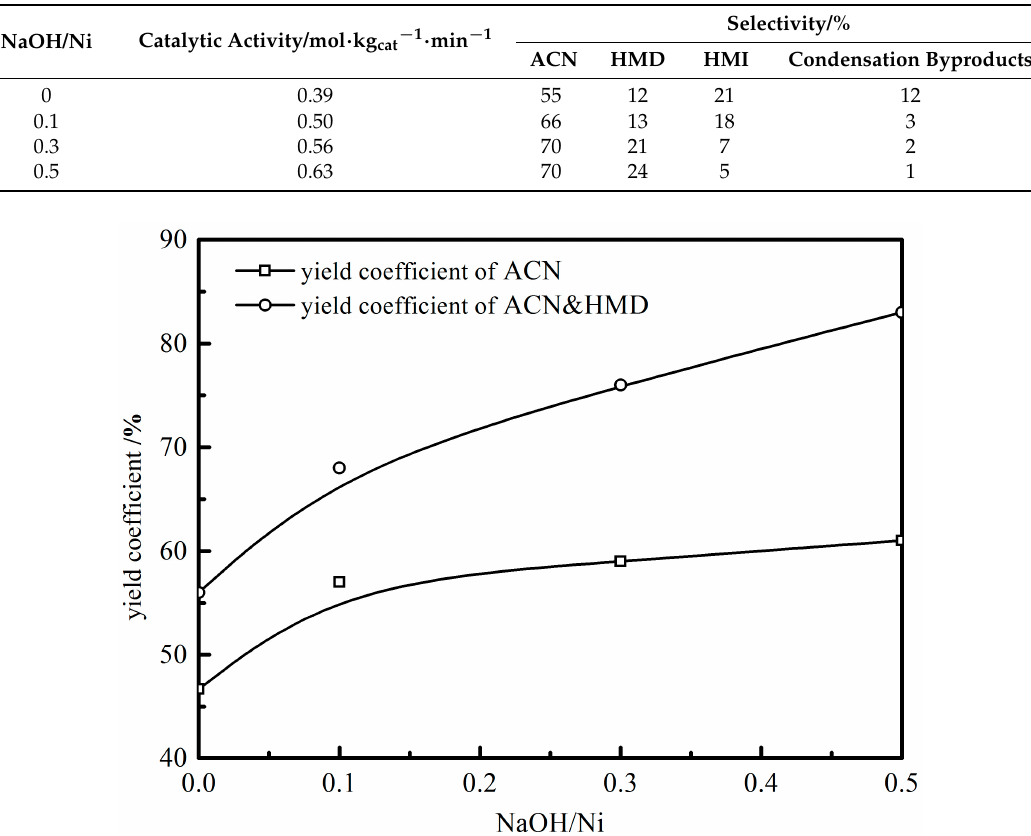
Figure 9. Evaluation result of catalysts with the use of different NaOH/Ni ratios.